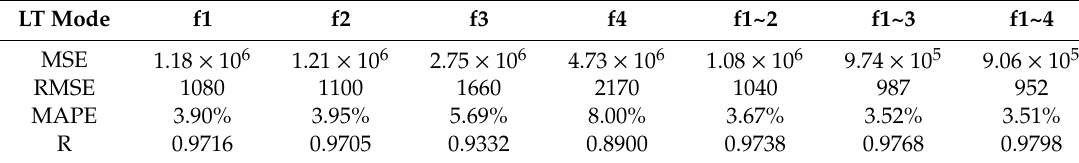
Table 10. Ei predicted by LT mode frequencies with ensemble.